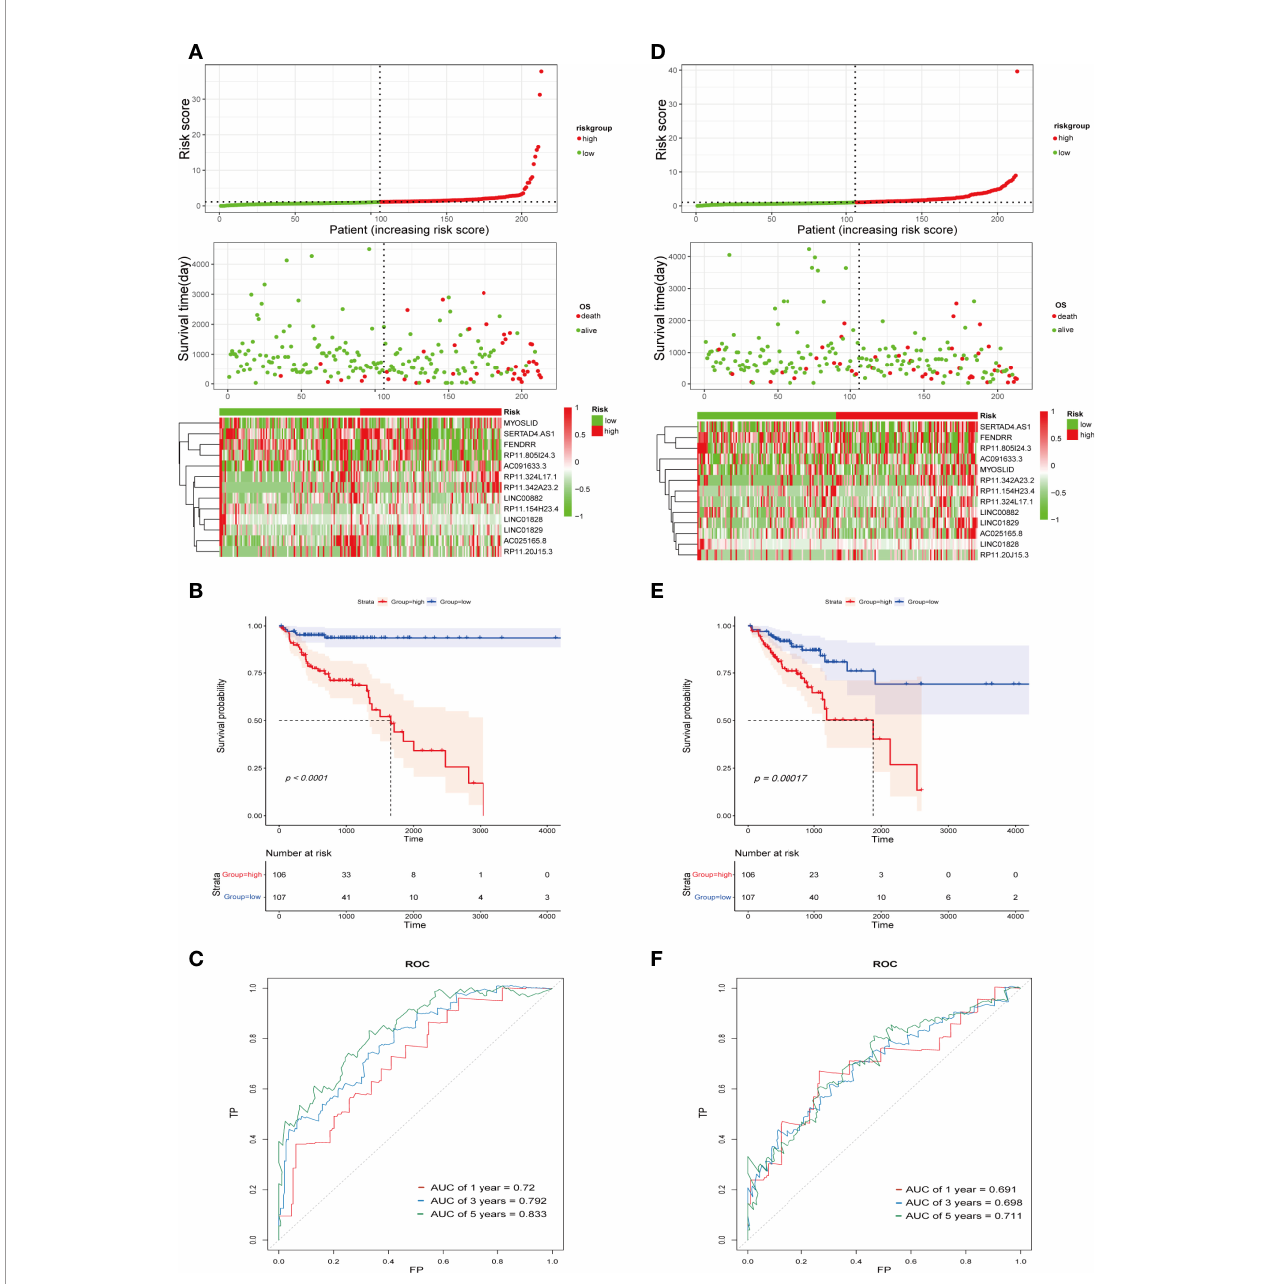
FIGURE 3 | Construction and validation of the IFN- g -related lncRNA prognostic signature in the training cohort and the validation cohort. (A, D) Correlation between the prognostic signature and the OS of patients in the training cohort (A) and validation cohort (D) . The distribution of risk score (upper), survival status (middle), and heatmap of selected IFN- g -related lncRNAs (below). (B, E) Kaplan-Meier survival curves of the OS for COAD patients between the high- and low-risk groups in the training cohort (B) and validation cohort (E) . (C, F) ROC curves of the IFN- g -related lncRNA prognostic signature for predicting 1-, 3-, and 5-year survival in the training cohort (C) and validation cohort (F)